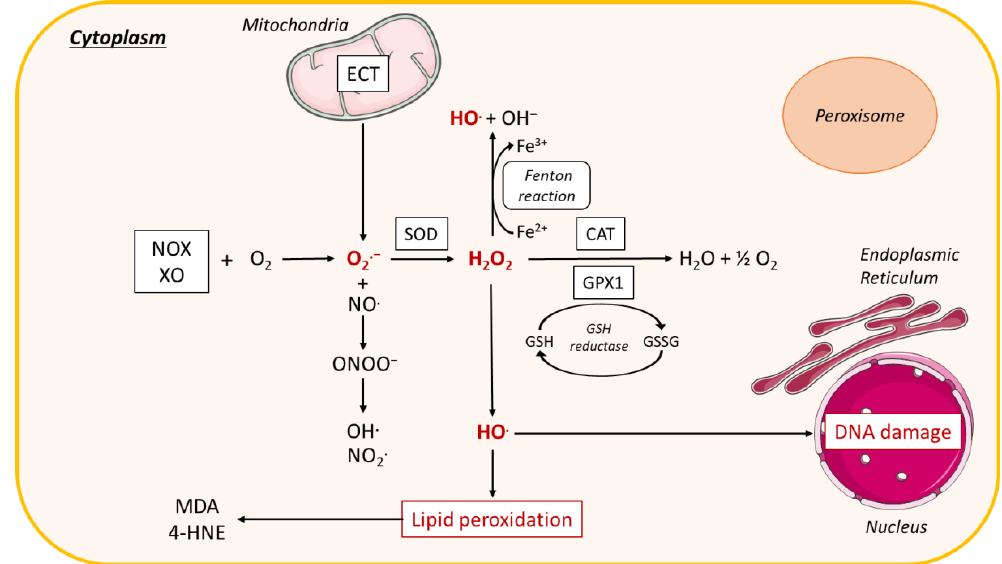
Figure 6. ROS production in the cytoplasm. In the cytoplasm, interaction of NADPH oxidase (NOX) and xanthine oxidase (XO) with oxygen (O 2 ) leads to the formation of superoxide radical (O 2 . − ). O 2 . − dismutation by the antioxidant enzyme superoxide dismutase (SOD) forms hydrogen peroxide (H 2 O 2 ), which is decomposed to O 2 and water (H 2 O) by the enzyme catalase (CAT) or the enzyme glutathione peroxidase 1 (GPX1), leading to the oxidation of reduced GSH into glutathione disulfide (GSSG). Reactive nitrogen species (RNS) are derived from nitric oxide ( . NO) and superoxide (O 2 . − ) produced via specific enzymes such as NADPH oxidase; the reaction of . NO with O 2 . − produces peroxynitrite (ONOO − ). ONOO − can react with other molecules to form additional types of RNS including nitrogen dioxide (NO 2 . ) as well as other types of chemically reactive free radicals ( . OH). H 2 O 2 forms a hydroxyl radical (HO . ), which causes lipid peroxidation leading to malondialdehyde